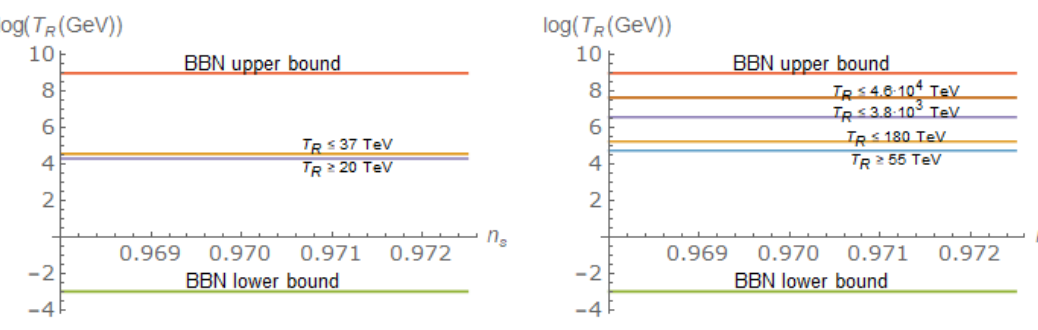
Figure 4. Relation between the reheating temperature T R in function of the spectral index n s for the potential in (2) ( left ) and the one in (106) ( right ), with the corresponding bounds for T R found in this